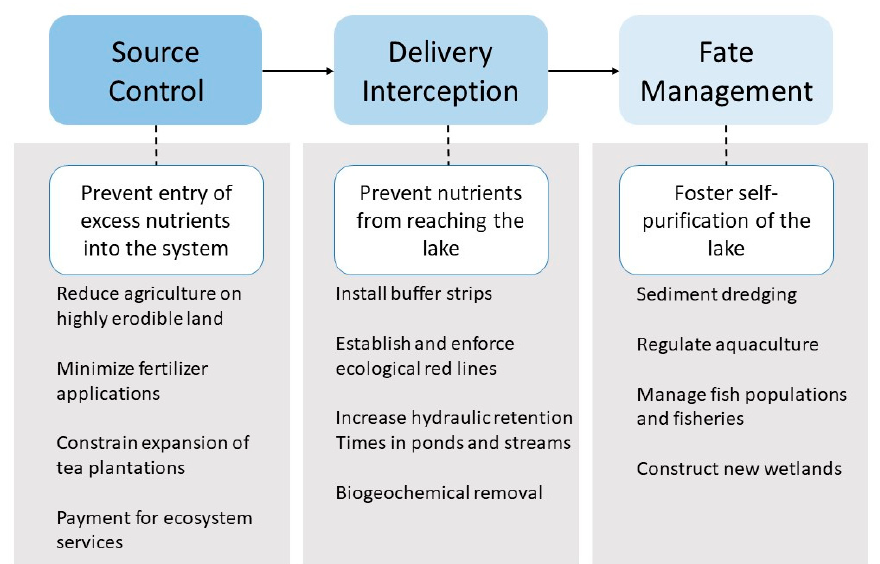
Figure 7. The diagrammatic representation of an integrative three-stage approach to control TN and TP pollution in hilly watersheds. The framework is based on analyses of the Tianmu Lake and Qiandao Lake watersheds but is meant to be generalizable. Strategies are identified by blue boxes, with brief explanations below in white boxes. Actions, which are grouped under each of the gray boxes, are representative and not comprehensive.